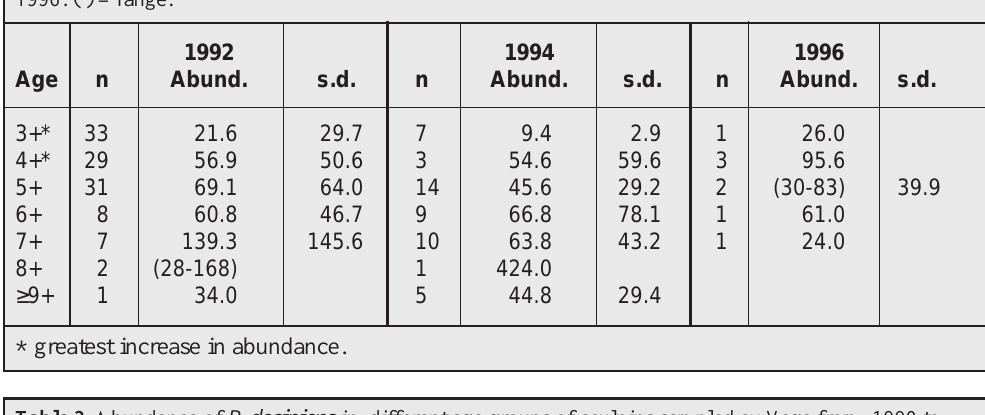
Table 2 . Abundance of P. decipiens in different age groups of sculpins sampled at Hvaler from 1992 to 1996. ( ) = range.